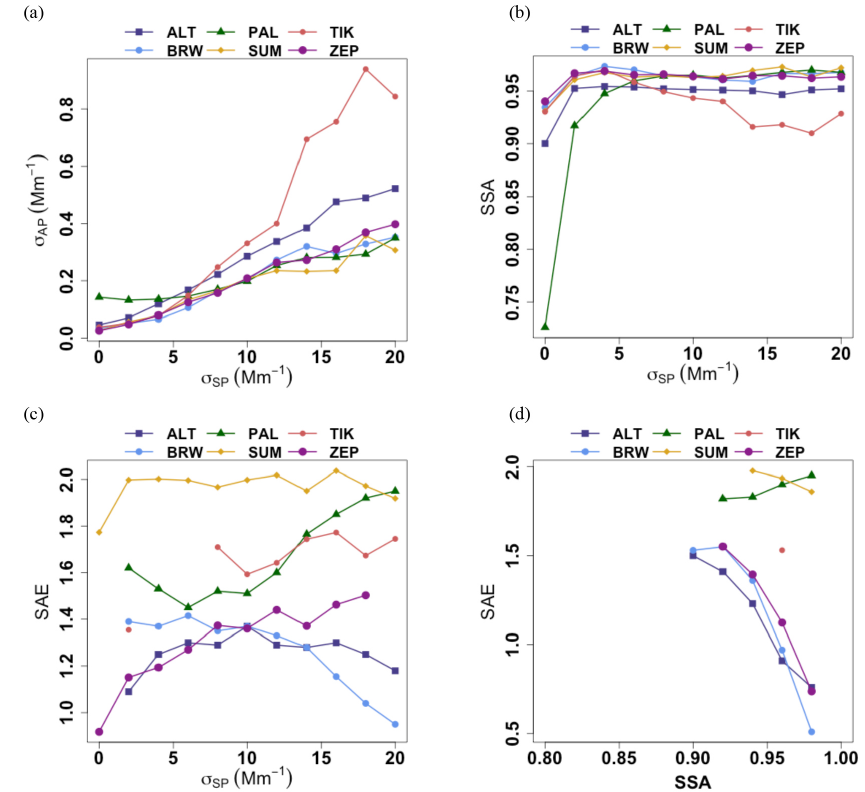
Figure 8. Systematic variability of median aerosol optical properties: (a) absorption varying with scattering coefficient, (b) single-scattering albedo varying with scattering coefficient, (c) scattering Ångström exponent varying with scattering coefficient, and (d) scattering Ångström exponent varying with single-scattering